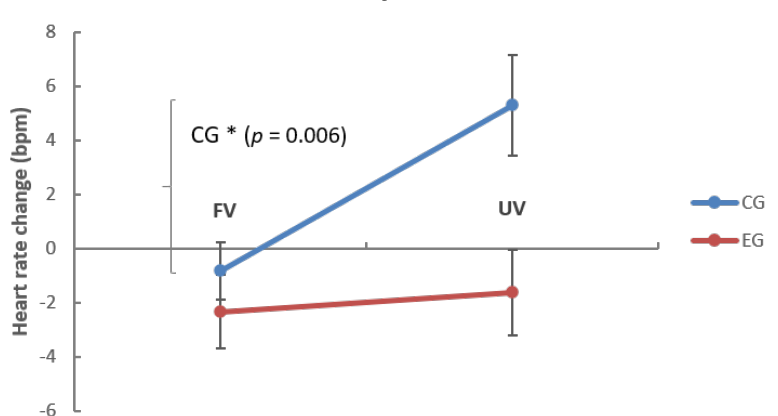
Figure 2. Change in HR (beats per minute) in dependence of voice familiarity. The figure shows the HR change (in beats per minute) from (4 × ) 180 s of the preceding baseline to (4 × ) 180 s stimulus presentation in infants who were prenatally exposed to auditory stimulation (EG; n = 22) and who were not exposed (CG; n = 12). Note that only in the CG did the HR increase to the unfamiliar voice, with respect to the HR change in the EG, that is not significantly di ff erent from baseline. HR = heart rate, EG = experimental group, CG = control group, FV = familiar voice, UV = unfamiliar voice. Data were pooled for both recordings two and five weeks after birth. Error bars refer to +/ − 1